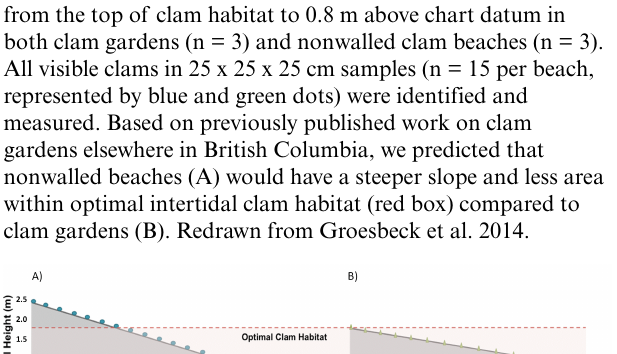
Fig. 2 . We surveyed clams across vertical transects that ran from the top of clam habitat to 0.8 m above chart datum in both clam gardens (n = 3) and nonwalled clam beaches (n =